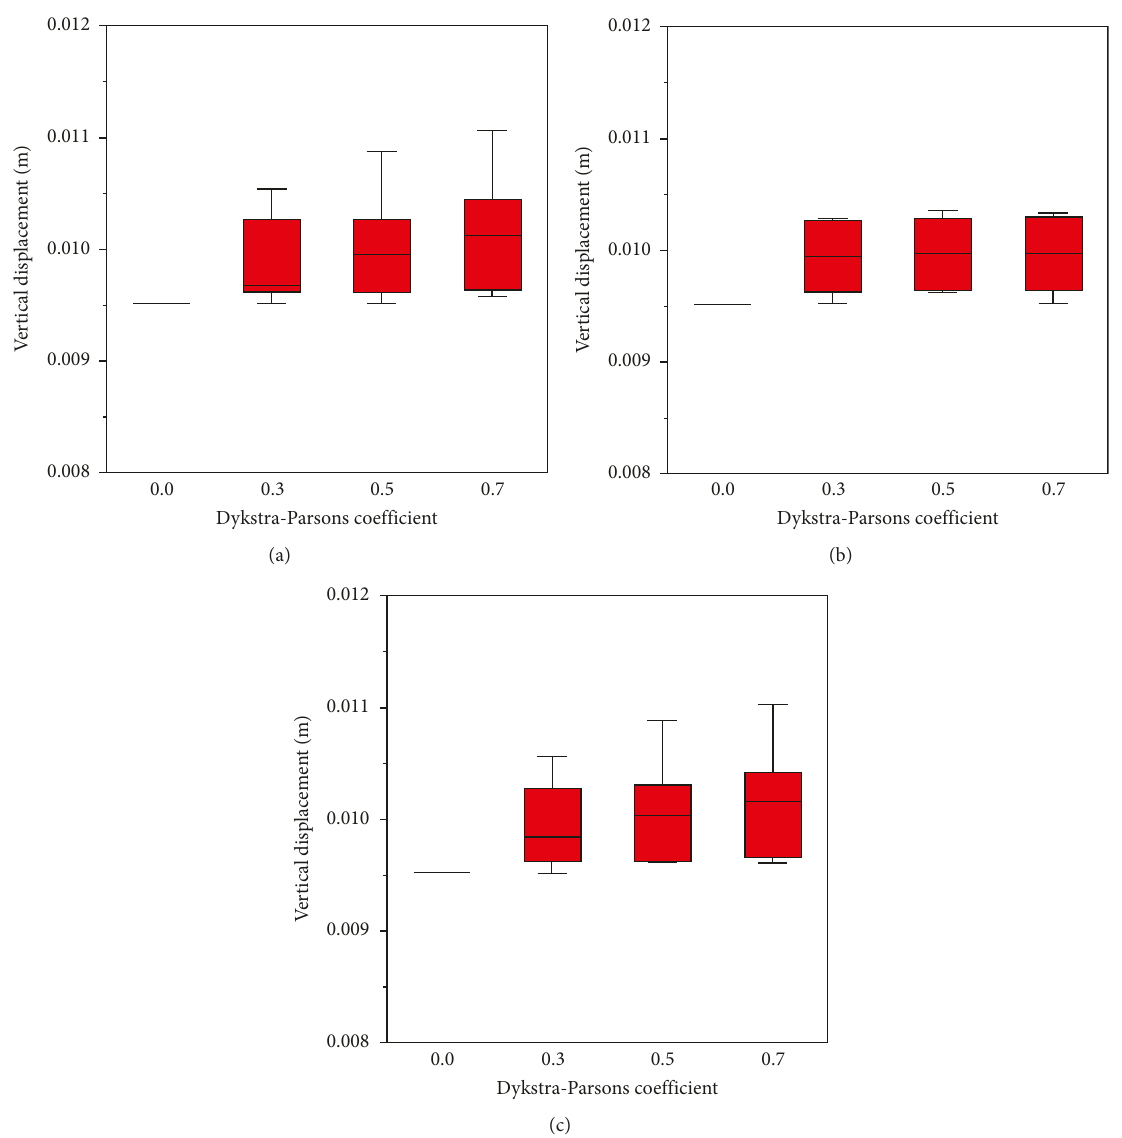
Figure 10: Box-whisker plots of vertical displacement: Cases A, B, and